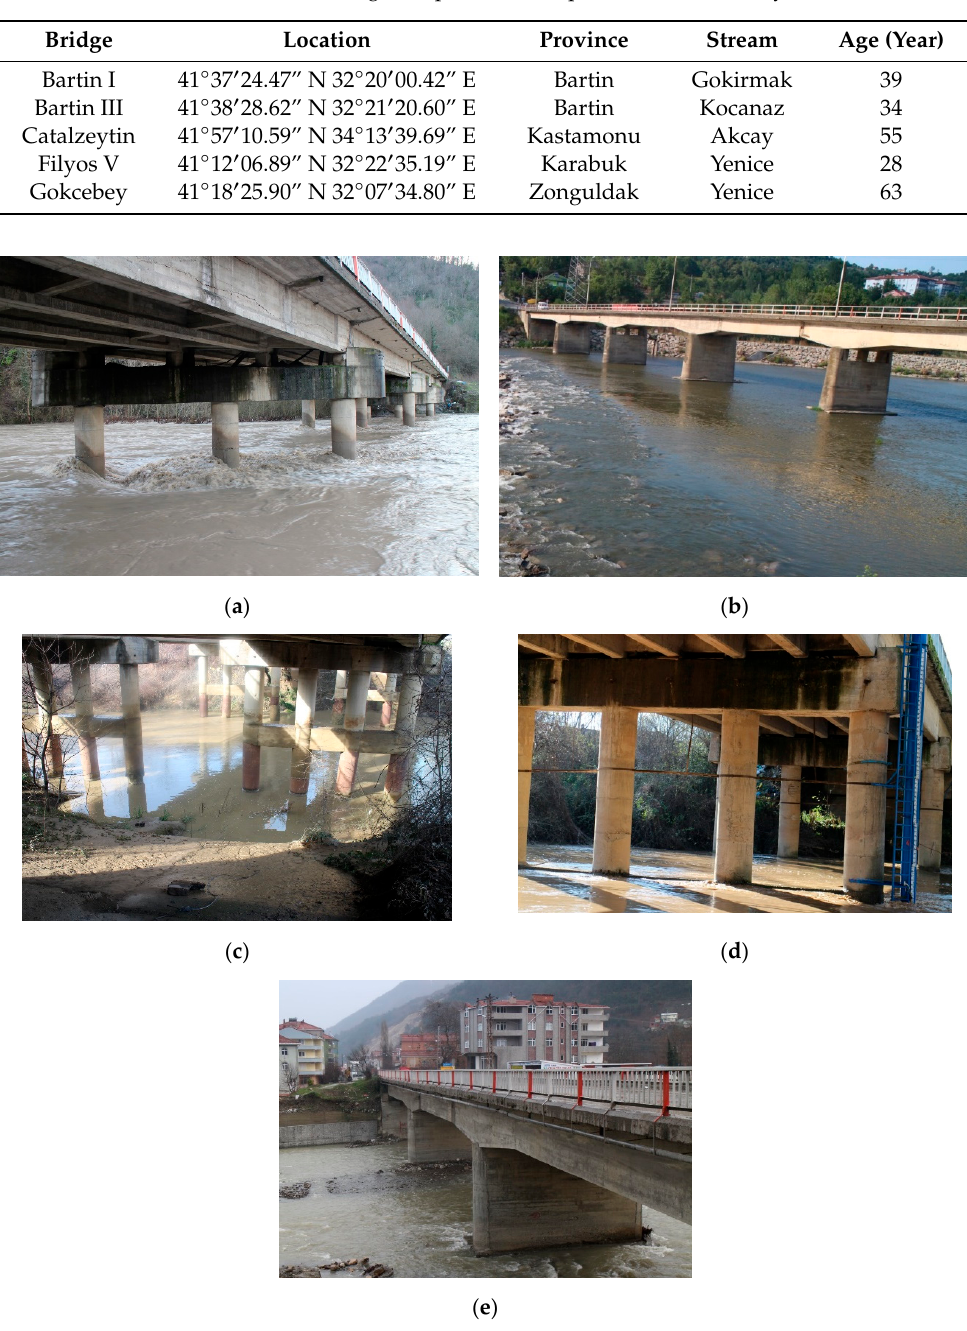
Figure 1. Bridges selected for full inspection: ( a ) Filyos V Bridge (April 2016); ( b ) Gokcebey Bridge (August 2017); ( c ) Bartin I Bridge (April 2017); ( d ) Bartin III Bridge (December 2014); ( e ) Catalzeytin Bridge (February 2016).